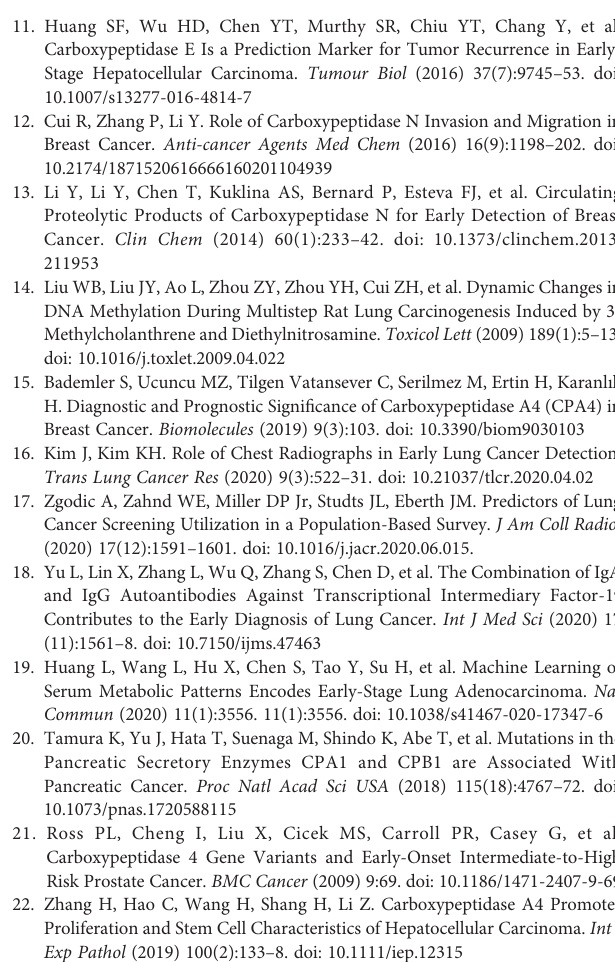
Supplementary Figure 1 | CPN2 transcription level upregulated in lung adenocarcinoma from TheCancer Genome Atlas (TCGA) cohort. (A, B) Scatter plot showing the expression of CPN2 between tumor and normal tissues, tumor and adjacent normal tissues in TCGA database, according to unpaired (A) and paired (B) t -test, respectively. ** P < 0.01, **** P < 0.0001. Supplementary Figure 2 | CPN2 co-expression genes in lung adenocarcinoma. (A) Volcano plot of CPN2 co-expression genes according to Pearson coef fi cient. Red dots denote a positive correlation, and blue dots denote a negative correlation. (B) Heat map of the top 50 signi fi cantly positively correlated genes with CPN2 . (C) Heat map of the top 50 signi fi cantly negatively correlated genes with CPN2 . Supplementary Figure 3 | Kyoto Encyclopedia of Genes and Genomes enrichment analysis of its interacted genes through Search Tool for the Retrieval of Interacting Genes/Proteins analysis showing the top 10 enrichment pathways according to the normalized enrichment score. False discovery rate <0.05 was considered statistically signi fi cant. Supplementary Figure 4 | CPN2 overexpression signi fi cantly promoted the migrationandinvasionabilityinlungcancercellwith CPN 2knockdownbyTranswell assay. Supplementary Table 1 | Primer sequences used for qRT-PCR. Supplementary Table 2 | Target sequences used for the knockdown of CPN2